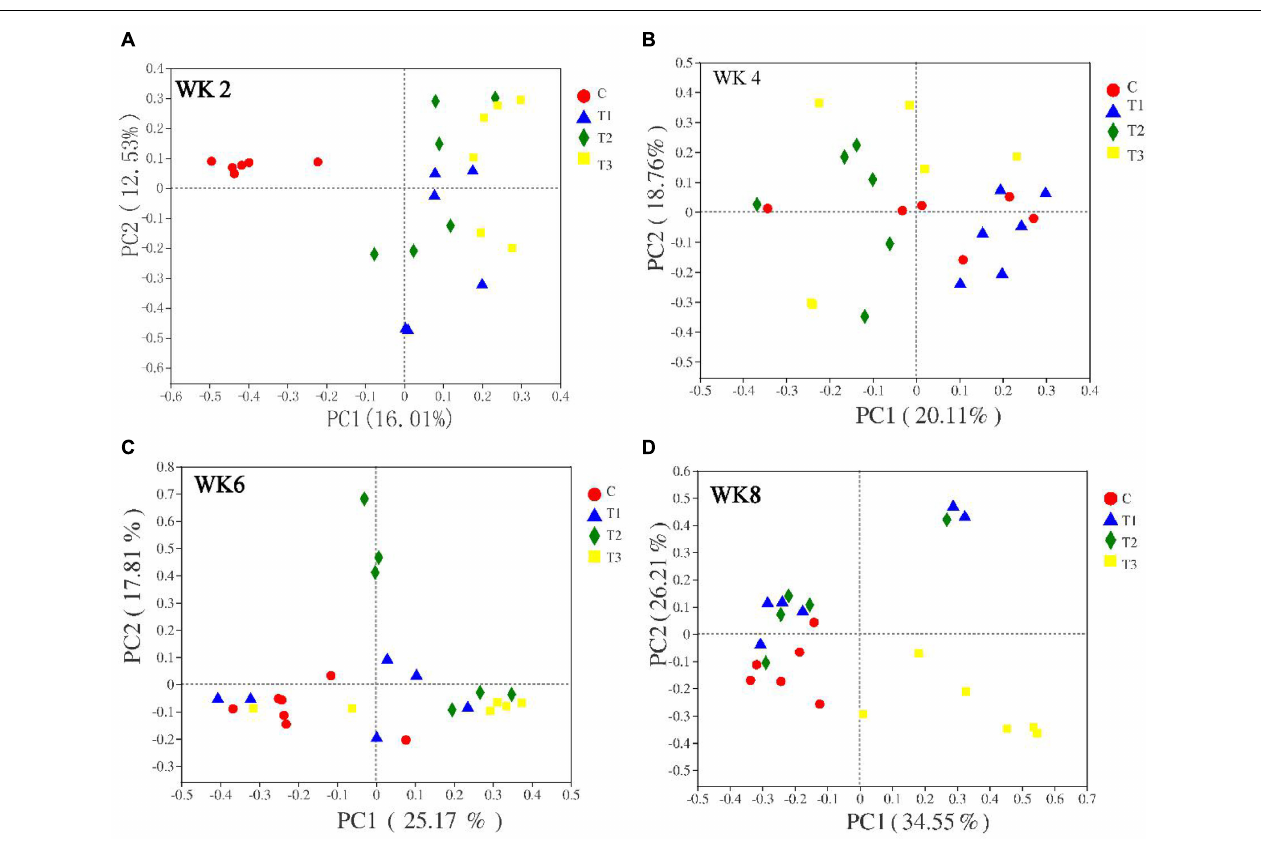
FIGURE 2 | Based on Bray–Curtis distance principal coordinates analysis (PCoA) (Panels A–D indicate WK2, WK4, WK6, and WK8 fungi PCoA pictures).